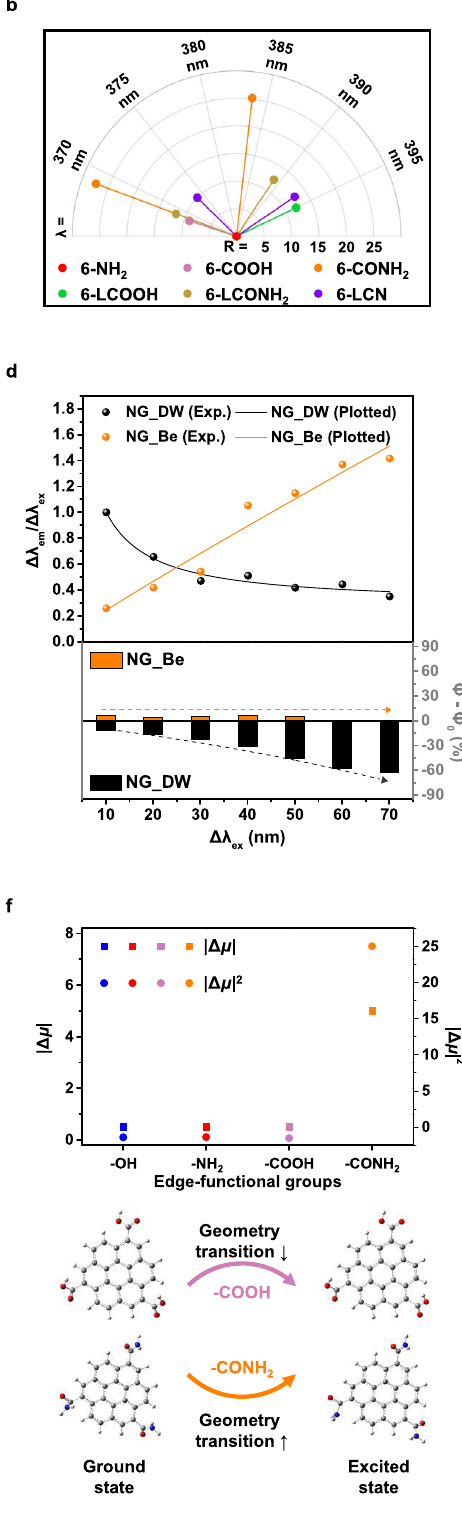
N-related surface states. In particular, according to the frontier molecular orbital (MO) and natural transition orbital (NTO) calculations in Supplementary Figs. 15 – 18, the -CONH 2 func- tional group at the edge of the NGs can induce an obvious decrease in the electron density delocalization in the HOMO and LUMO as well as spatial HOMO-LUMO separation, resulting from its highly distorted molecular structure 26 . Additionally,